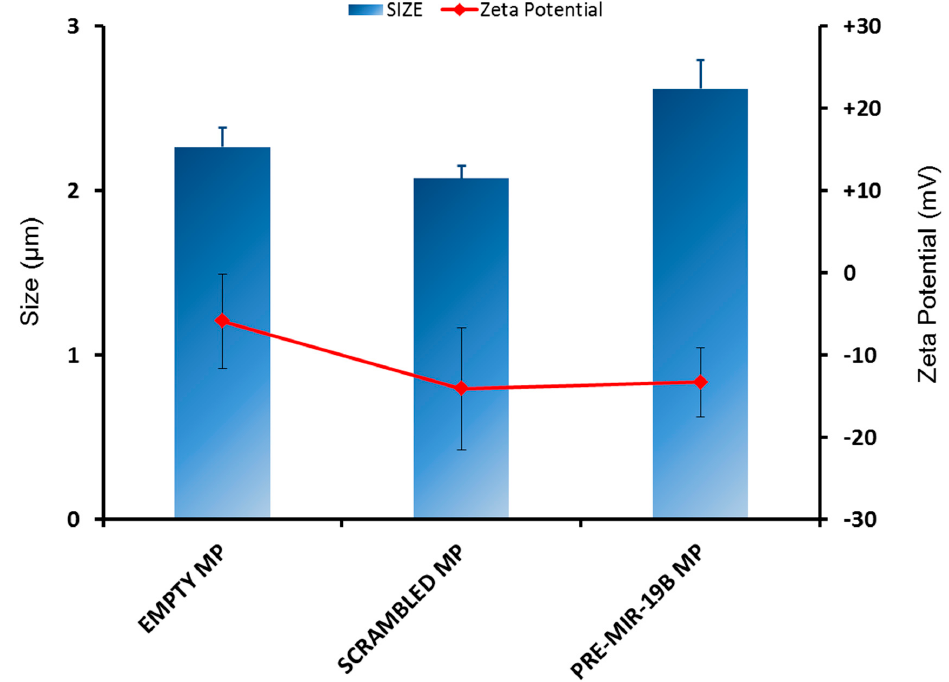
Figure 1. Size and ζ potential of poly (lactic- co -glycolic acid) (PLGA) formulations. Empty (no RNA) PLGA microparticles (MP) and scrambled non-targeting- or pre-miR-19b mimic-loaded PLGA MPs were prepared using a double emulsion, solvent evaporation method. Size (volume median diameter, µ m) of PLGA MPs was determined in triplicate using laser diffraction (Mastersizer 2000, Malvern, UK), blue bars. ζ potential (mV) of PLGA microparticles was determined ( n = 5 technical replicates, red line) using Laser Doppler Velocimetry (Zetasizer Nano ZS, Malvern, UK). Data are depicted as mean ± SEM, n ≥ 3.